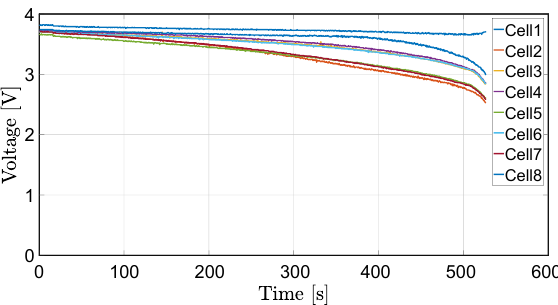
Figure 15. The discharging process of the cells without balancing circuit.